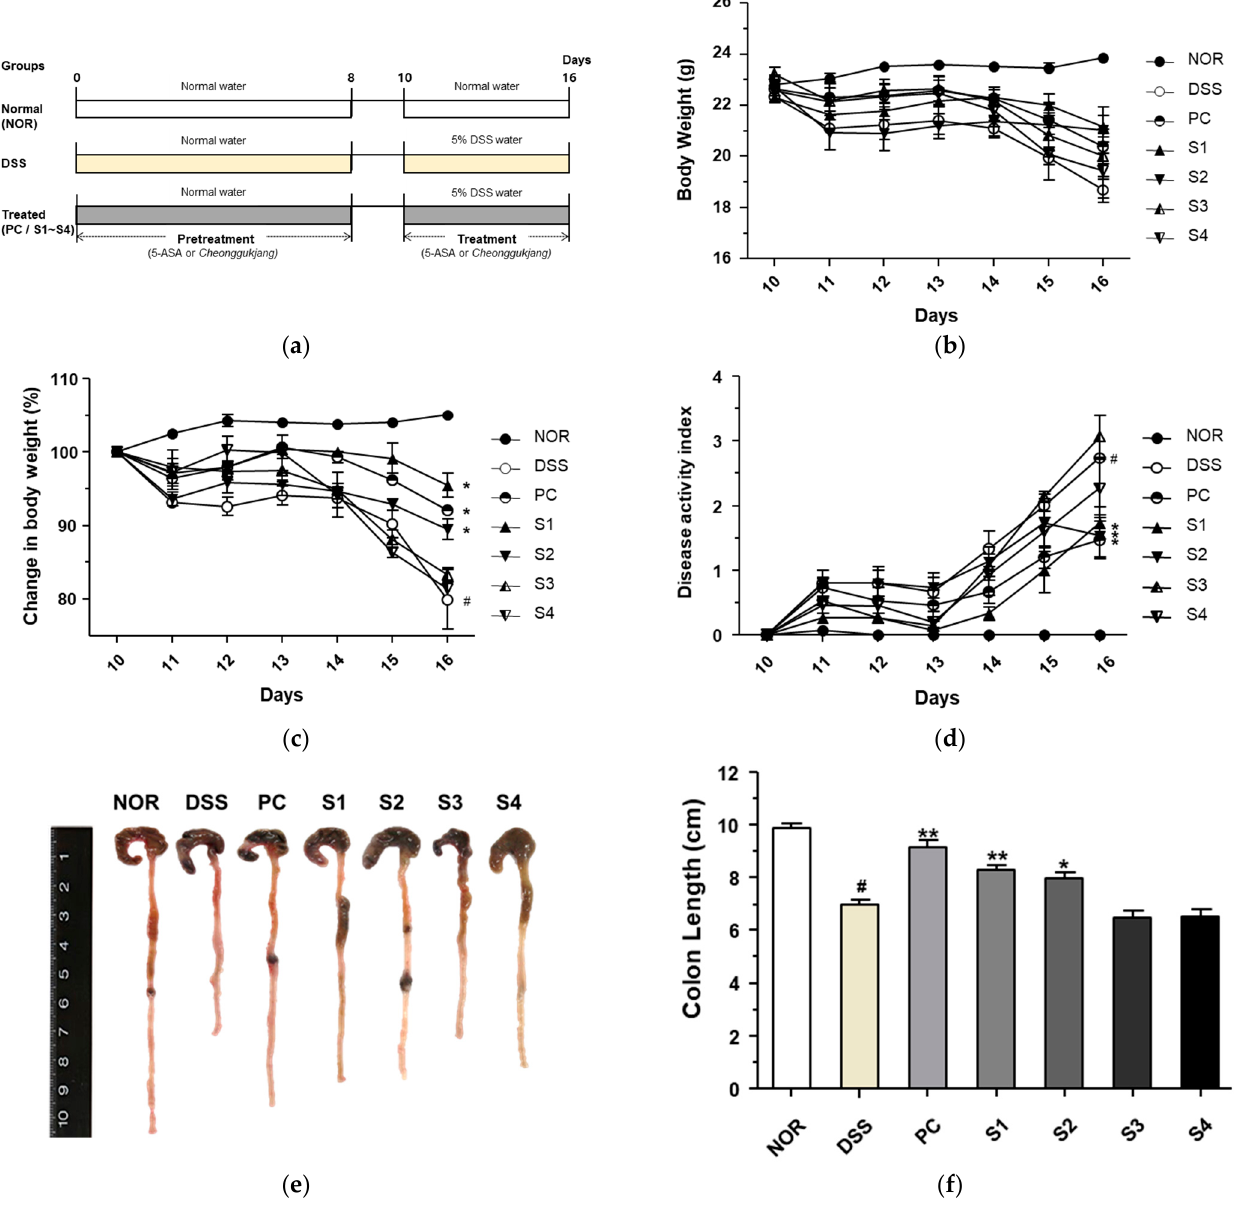
Figure 2. Protective effect of Cheonggukjang on the progression of dextran sulfate sodium (DSS)- induced colitis. ( a ) Schematic representation for animal experiments; ( b ) Body weight (g); ( c ) Change in body weight (%); ( d ) Disease activity index; ( e ) Representative images of colon tissue in each group; ( f ) Colon length (cm). Values are presented as the mean ± standard deviation (SD) (n = 5); #, p < 0.005 versus normal group; **, p < 0.005; *, p < 0.05 versus DSS group.